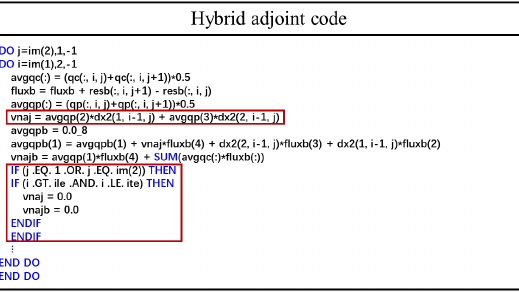
Figure 6. The raw adjoint codes corresponding to the calculation of convective flux.